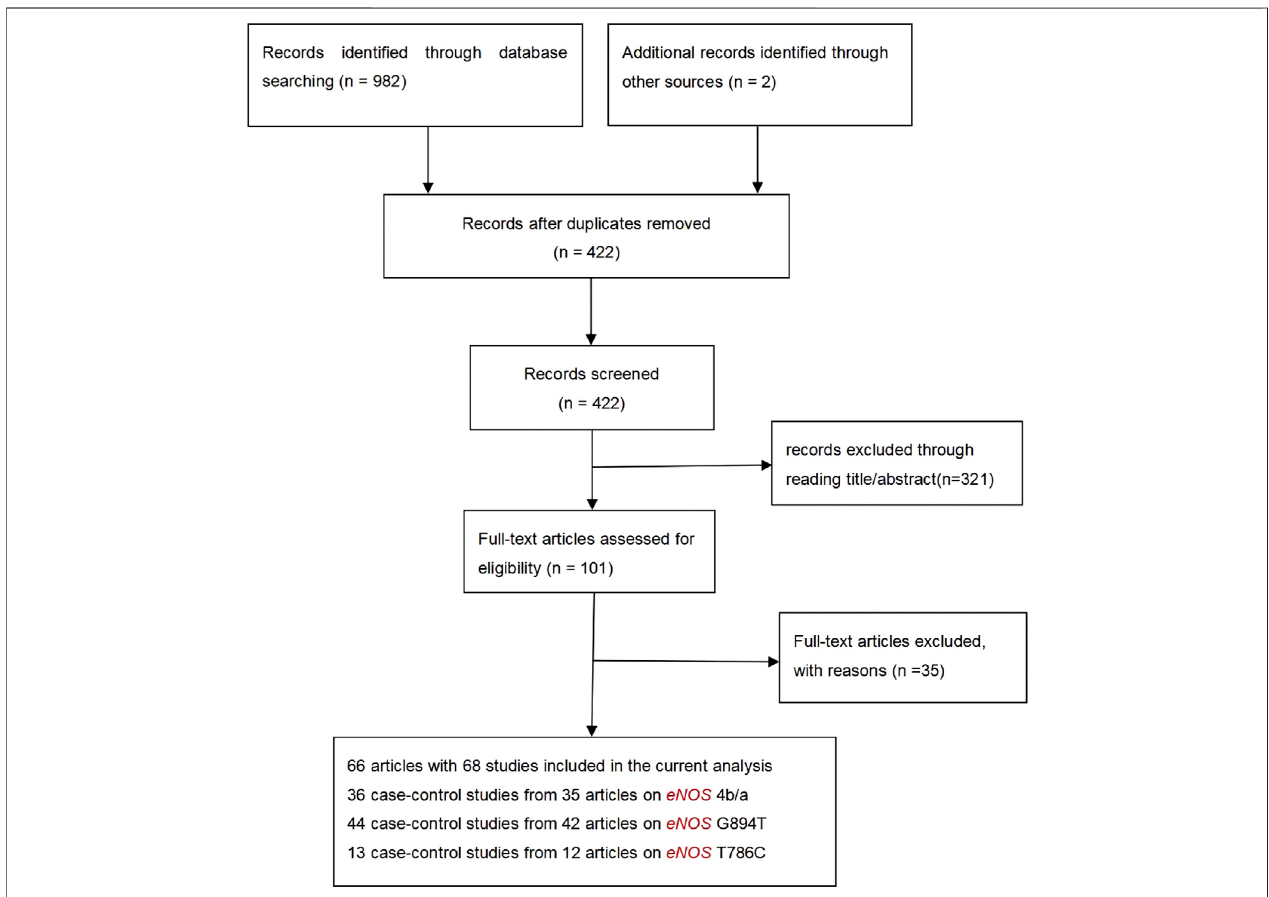
FIGURE 1 | Flow diagram of the literature